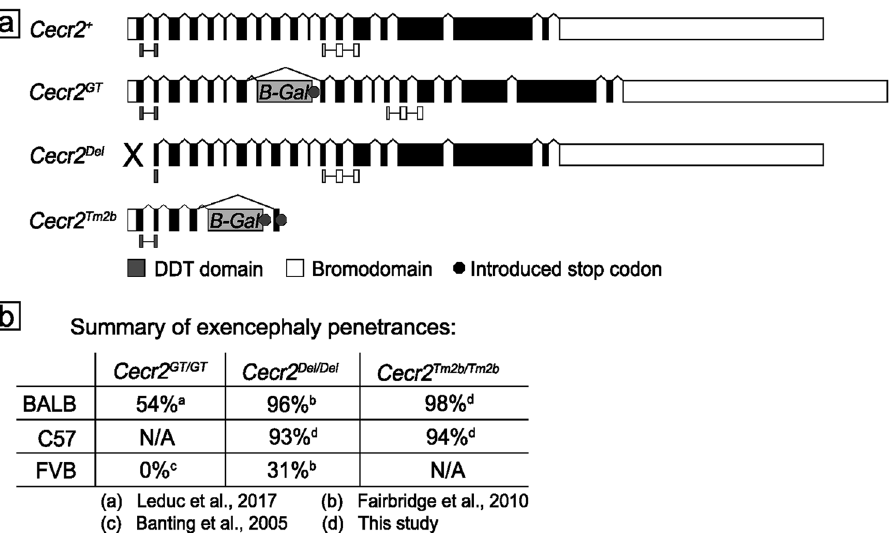
Figure 1. Cecr2 mutations used in this study. Four alleles were used and the abbreviated notations of the 3 mutations used throughout this report are shown ( a ). The wildtype allele has 19 exons. A DDT domain is present in exons 1–2 and a bromodomain is located in exons 12–14. The Cecr2 GT (Cecr2 Gt(pGT1)1Hemc ) genetrap allele results from a β-Gal construct inserted between exons 7 and 8, resulting in a CECR2/LacZ-fusion protein. However, the hypomorphic mutation is leaky and some full-length transcript is made, presumably by splicing around the genetrap. The presumptive null Cecr2 Del (Cecr2 tm.1.1Hemc ) deletion allele is the result of deleting exon 1 and ~ 1 kb upstream. The presumptive null allele Cecr2 tm2b (Cecr2 tm2b(EUCOMM)Hmgu ) is a β-Gal gene trap that produces a CECR2/LacZ-fusion protein, but also has Cecr2 exon 4 excised, which puts all transcripts out of frame. A summary of the exencephaly penetrances of these mutations on different strain backgrounds ( b ) highlights the difference between the hypomorphic Cecr2 GT allele and the two presumptive null alleles and also the dramatic effect background strain has on the exencephaly